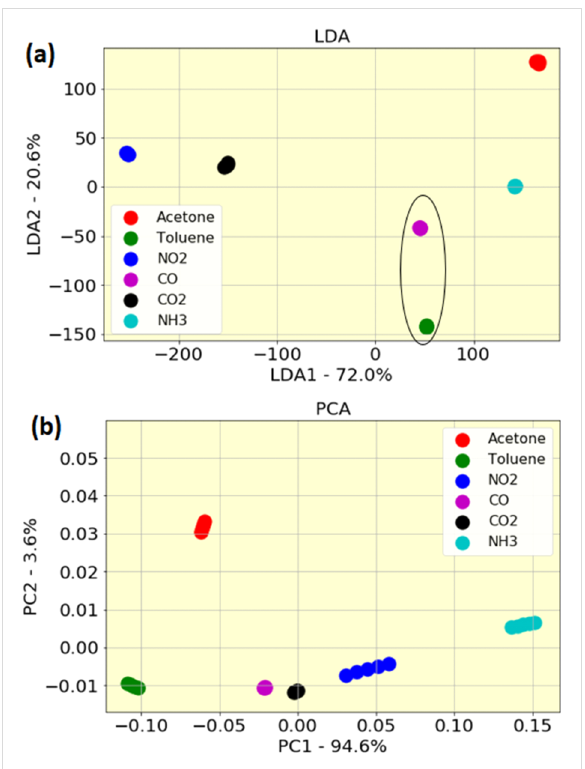
Figure 11: Two-dimensional (a) LDA and (b) PCA projections of extracted features.